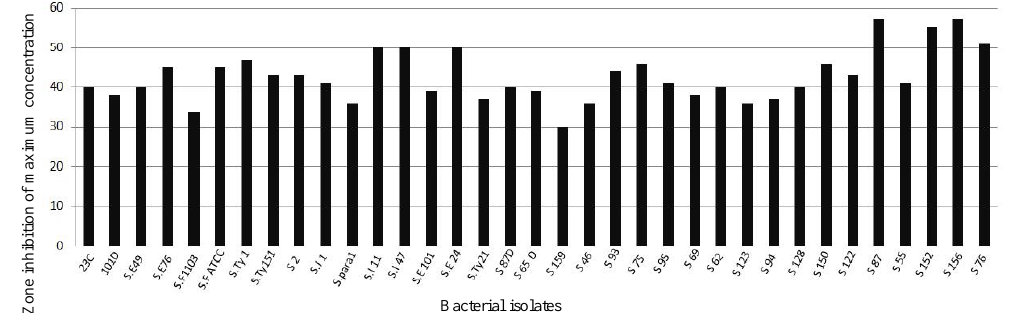
Figure 1. The susceptibility results of Salmonella isolates to the serial (maximum) concentrations of Aloe vera var. littoralis extract .